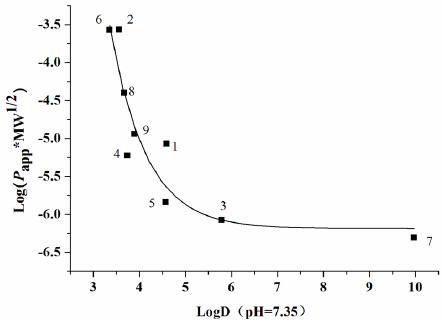
Figure 3. The relationship between log ( P app AP → BL × MW 1/2 ) and log D (pH = 7.35) for nine phenolic acid esters ( 1 – 9 ).